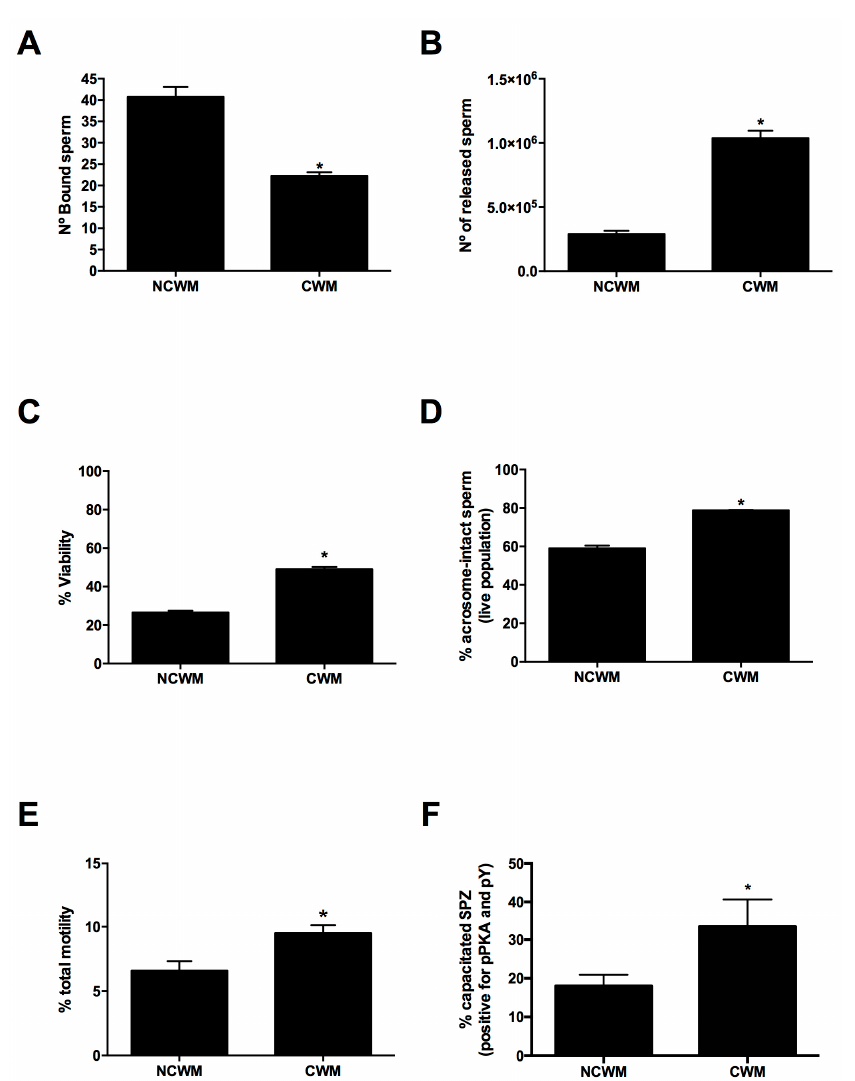
Figure 5. Characterization of sperm released from OECs primary cultures. OEC and sperm co- cultures were incubated for 15 min at 37 ◦ C in the presence of NCWM (no capacitating condition) or CWM (capacitating condition) and the spermatozoa bound ( A ) to OECs were quantified using bright field microscopy while ( B ) the released sperm were recovered and quantified with a hemocytometer. Bars represent the mean ± SEM of bound spermatozoa/0.11 mm 2 monolayer ( A ) and ( B ) the mean ± SEM of the number of released sperm. * p < 0.05, n = 6. ( C ) Sperm released from the co- cultures were incubated with Hoechst 33258, fixed and the percentage of live sperm was determined using fluorescence microscopy. Bars represent the mean ± SEM of live spermatozoa. * p < 0.05, n = 6. ( D ) Sperm viability and acrosome status were evaluated as described in Section 2. Bars represent the mean ± SEM of live spermatozoa with intact acrosomes. * p < 0.05, n = 6. ( E ) The total motility of released sperm was determined by CASA. Bars represent the mean ± SEM of total motile spermatozoa. * p < 0.05, n = 6. ( F ) OEC-released sperm positive for pPKA and pY were evaluated using immunofluorescence. Bars represent the mean ± SEM of live sperm. * p < 0.05, n = 6.